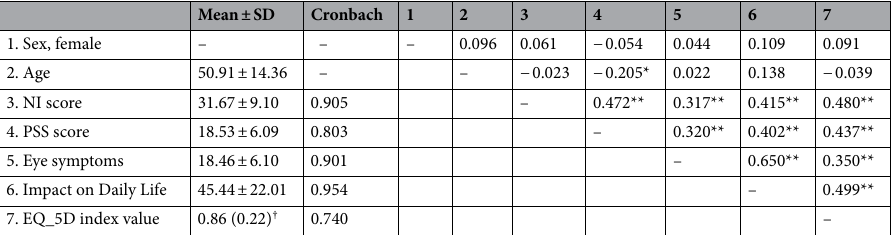
Table 2. Mean score of each item of the DEQS-TH and the correlations with age, sex, NI and PSS scores using Pearson’s among participants with DED. DEQS Dry Eye-related Quality-of-Life Score, SD standard deviation, DED dry eye disease, NI Neuroticism Inventory, PSS Perceived Stress Scale, EQ‑5D EuroQoL-5 dimension, *p < 0.05, **p < 0.01, ***p < 0.001, † median (interquartile